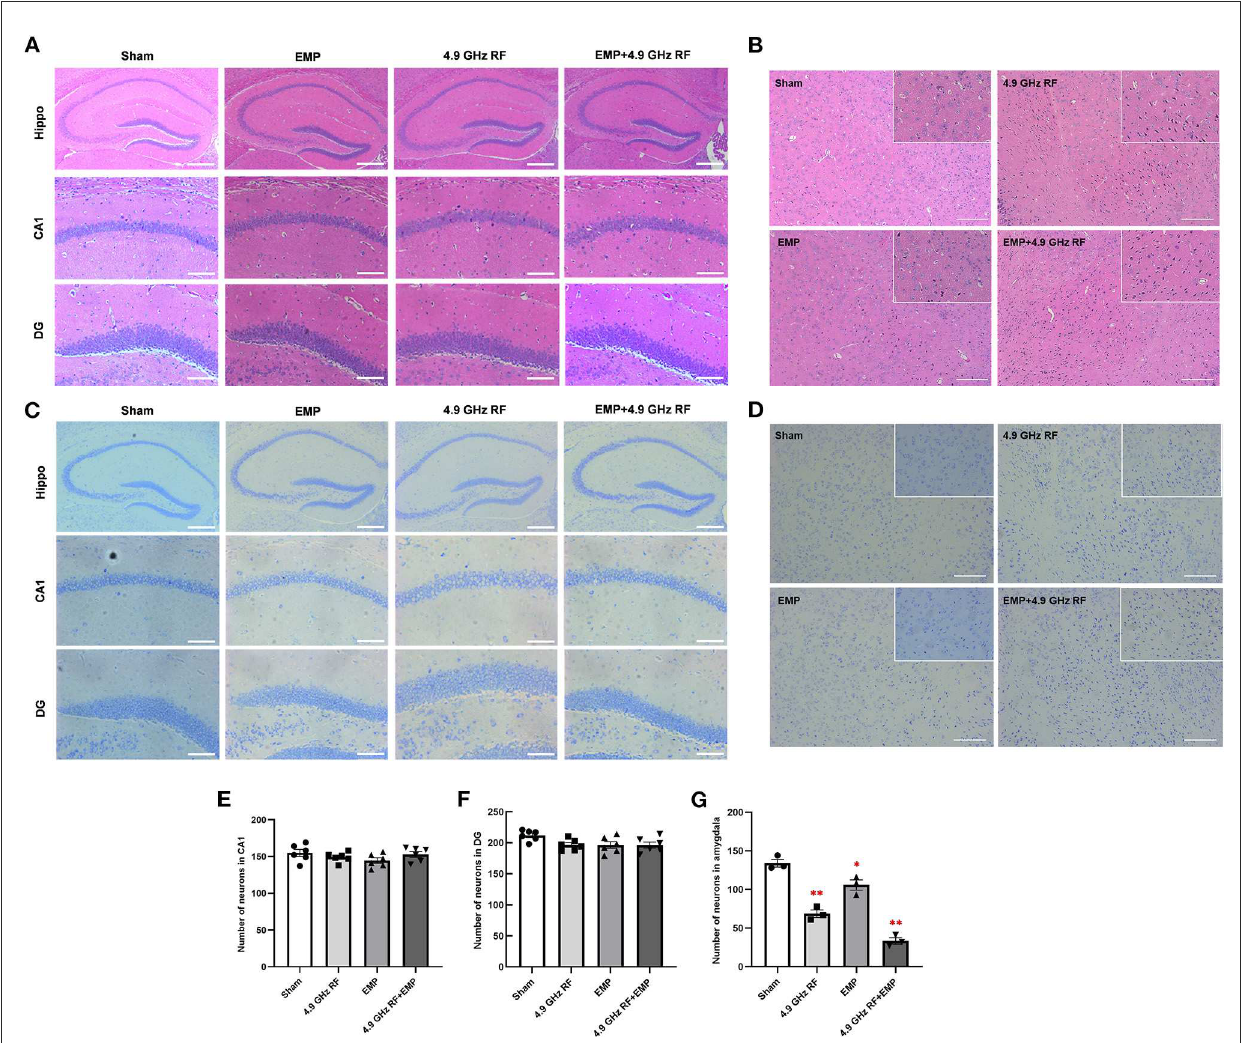
FIGURE6 The combined effects of exposure to EMP and 4.9 GHz RF on the histology of brain. (A) HE staining of hippocampal morphology in CA1 and DG regions. (B) HE staining of amygdala. (C) Nissl staining of hippocampal CA1 and DG regions. (D) Nissl staining of amygdala. The number of neurons in CA1 region (E) and DG region (F) , six random fields were chosen for each group. (G) The number of neurons in amygdala. n = 3 for each group. Scale bar = 200 µ m for hippocampus (Hippo); scale bar = 100 µ m for amygdala; scale bar = 50 µ m for CA1, DG and magnified images of amygdala. * P < 0.05, ** P < 0.01 vs. Sham